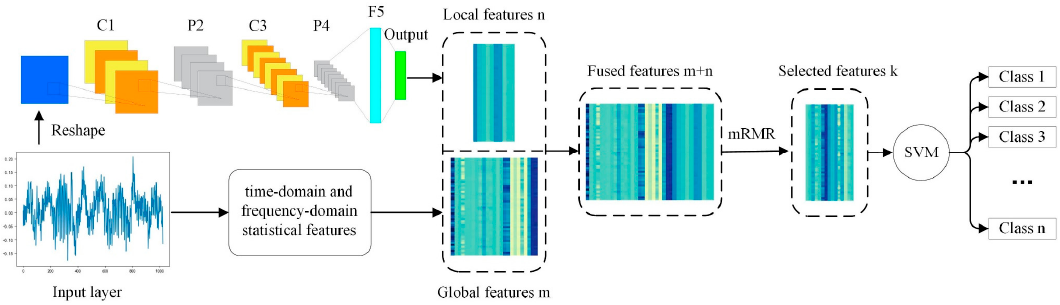
Figure 3. Schematic diagram of GL-mRMR-SVM.